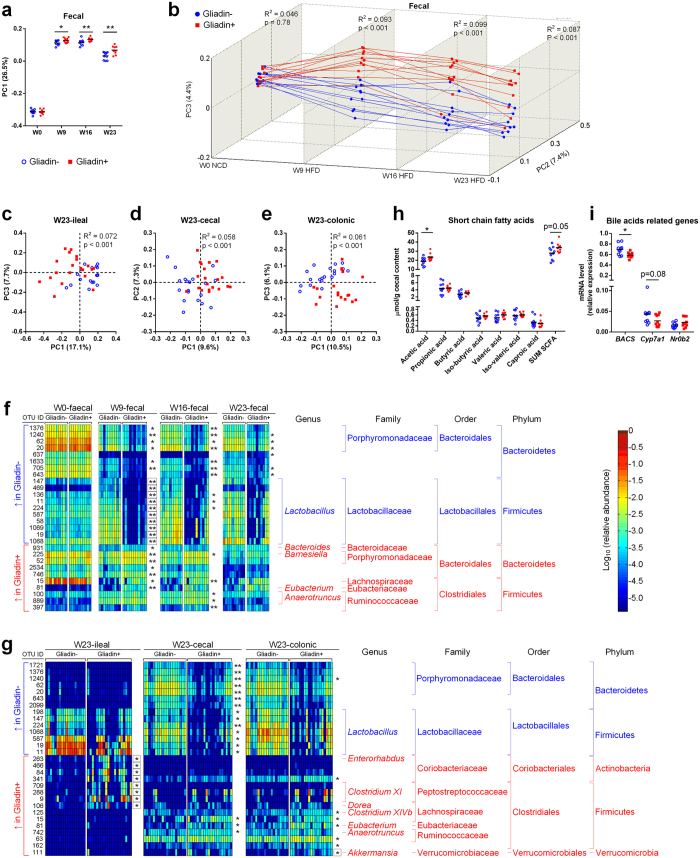
Gliadin intake altered intestinal microbial composition and activity.Microbiota analysis was performed on faecal samples collected from 10–11 cages per group at Week 0, 9, 16 and 23 and on terminal ileal, caecal and colonic luminal samples (n = 18–20 mice per group) by sequencing the V3 region of bacterial 16S rRNA genes followed by PCoA on unweighted UniFrac distances (a–e). Panel (a) shows that the HFD feeding, initiated after Week 0, affected the first coordinate (PC1) of the microbiota composition, while (b) shows the longitudinal effect of Gliadin feeding. Panels (c–e) show that Gliadin feeding affected the ileal, caecal and colonic microbiota in samples obtained at termination. In panel (a), asterisks represent significant differences between the two groups (*p < 0.05, **p < 0.01, unpaired t test or Mann-Whitney test), while in panels (b–e), p values are listed for differential clustering (ADONIS test) and R2 values represent the percentages of variation explained by gliadin intake. NCD designates Normal Chow Diet, HFD designates High-Fat Diet. Heatmaps (f,g) show the relative abundances of OTUs differing between the Gliadin− and Gliadin+ mice in faecal and intestinal samples. Taxonomy is reported at the lowest identifiable level. OTUs that are more abundant in the Gliadin+ group are indicated in red and those less abundant in blue. Statistical comparison of the two groups was done by 10,000 times of permutation; p values represent fraction of times that permuted differences assessed by Welch’s t test were greater than or equal to real differences, and were adjusted by FDR correction71 (*q < 0.05, **q < 0.01). Boxes surrounding asterisks indicate >ten-fold differences in OTU abundances between the two groups. For faecal samples, only OTUs that have at least one q < 0.02 are shown. Short chain fatty acid concentrations in caecum (h) and hepatic mRNA levels of bile acid related genes (i) were measured at termination (n = 9–10 non-fasted mice per group). The mean of each group is shown by a horizontal line. Asterisks represent statistically significant differences (*p < 0.05, unpaired t test or Mann-Whitney test). See also Supplementary Fig. S2.